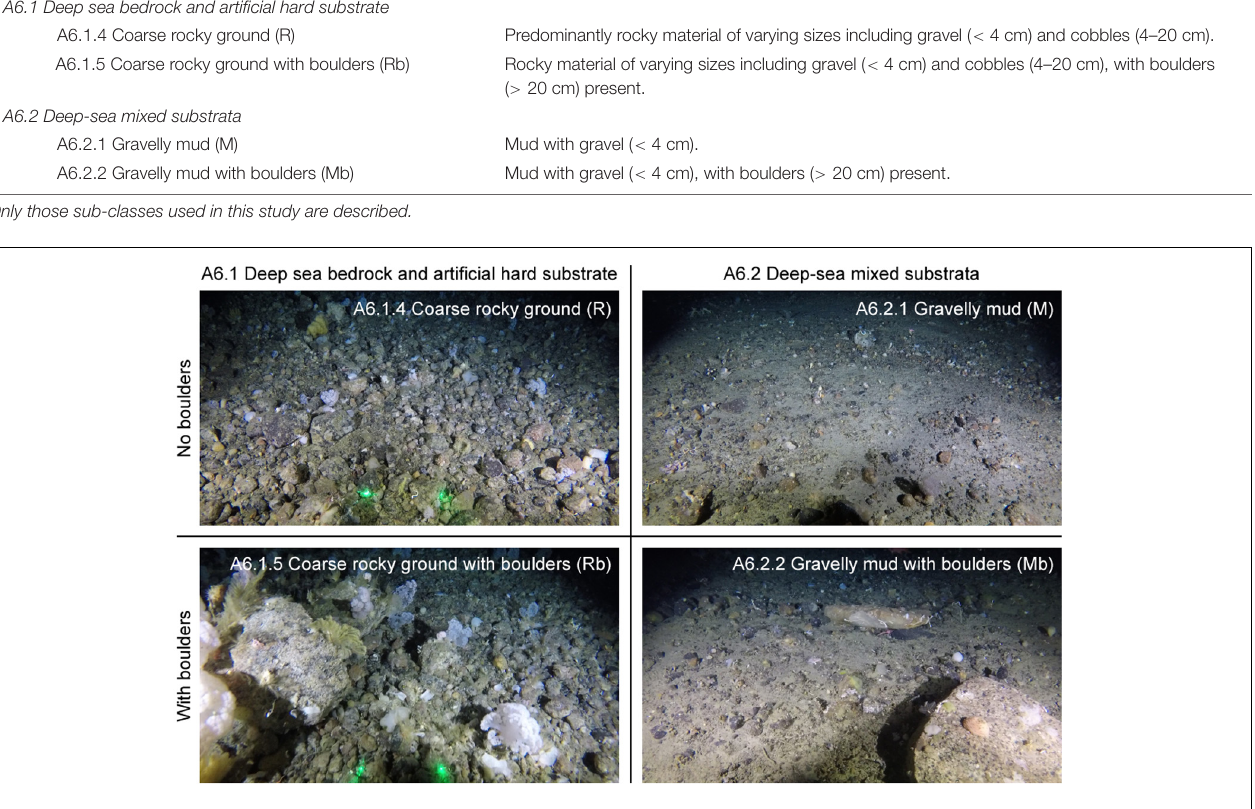
FIGURE 3 | Example image of each type of substrate class used to label images sampled from videos. Substrate classes are based on the revised EUNIS Habitat Classification (Davies et al., 2004), as adapted by Gougeon et al. (2017) and further modified here. Examples are taken from images used in the analysis. Where present laser dots (green) are 20 cm